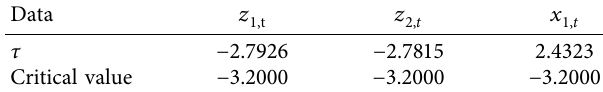
, z , and x 1 ,t 2 ,t 1 ,t